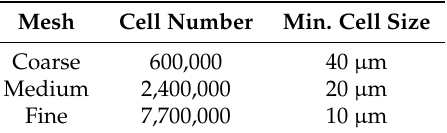
Figure 8. Computational grid. Table 3. Mesh characteristics.